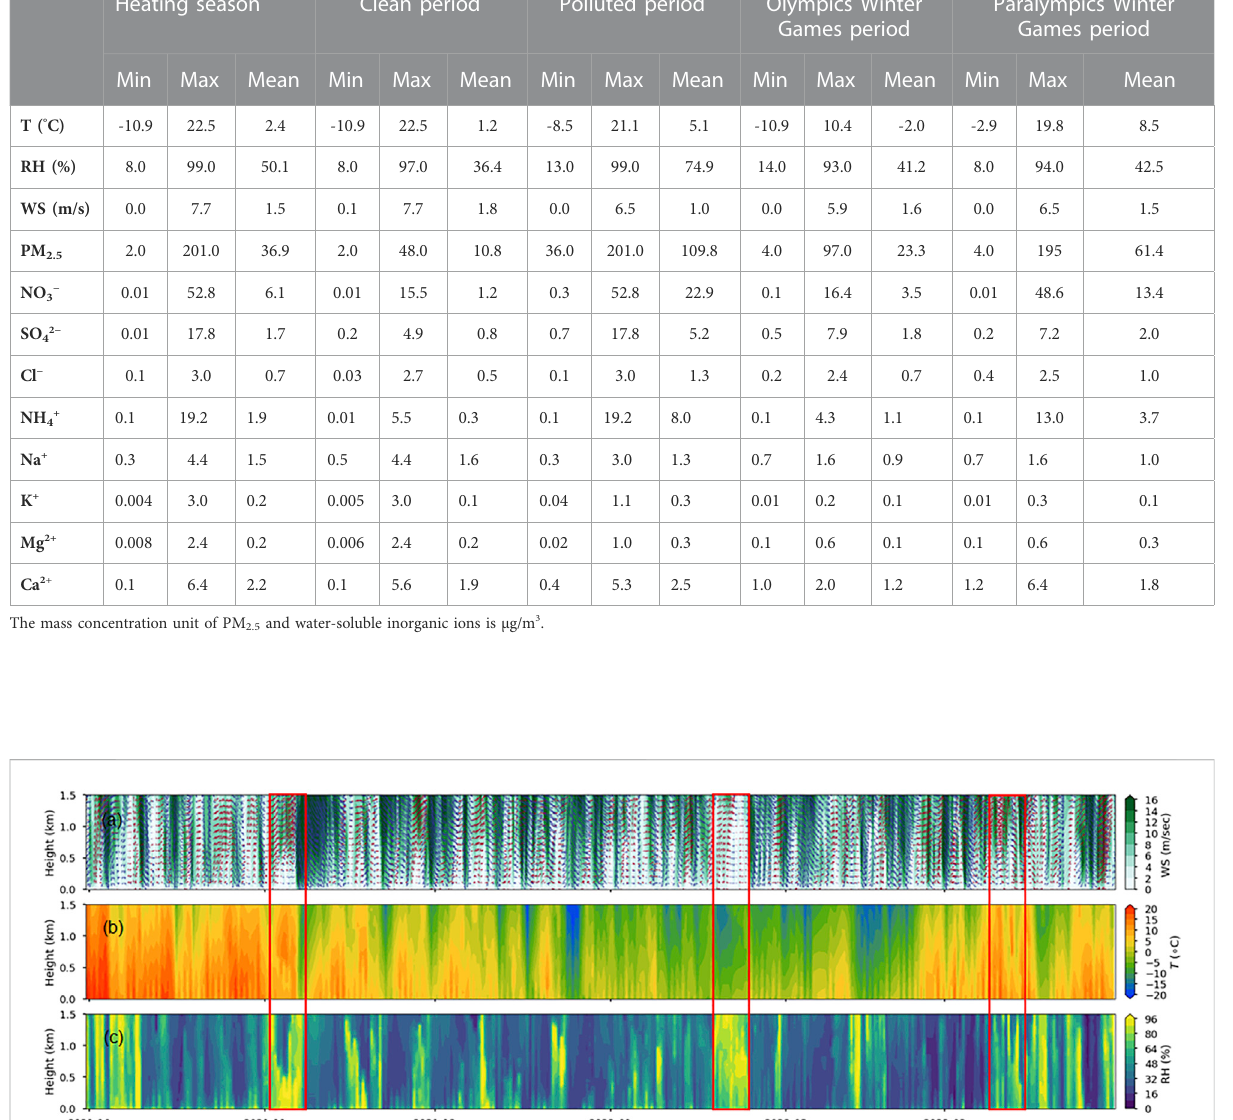
TABLE 1 Hourly meteorological factors, hourly mass concentration of PM 2.5 and its water-soluble inorganic ions during the clean period, polluted period, Olympics Winter Games period, and Paralympics Winter Games period. Heating season